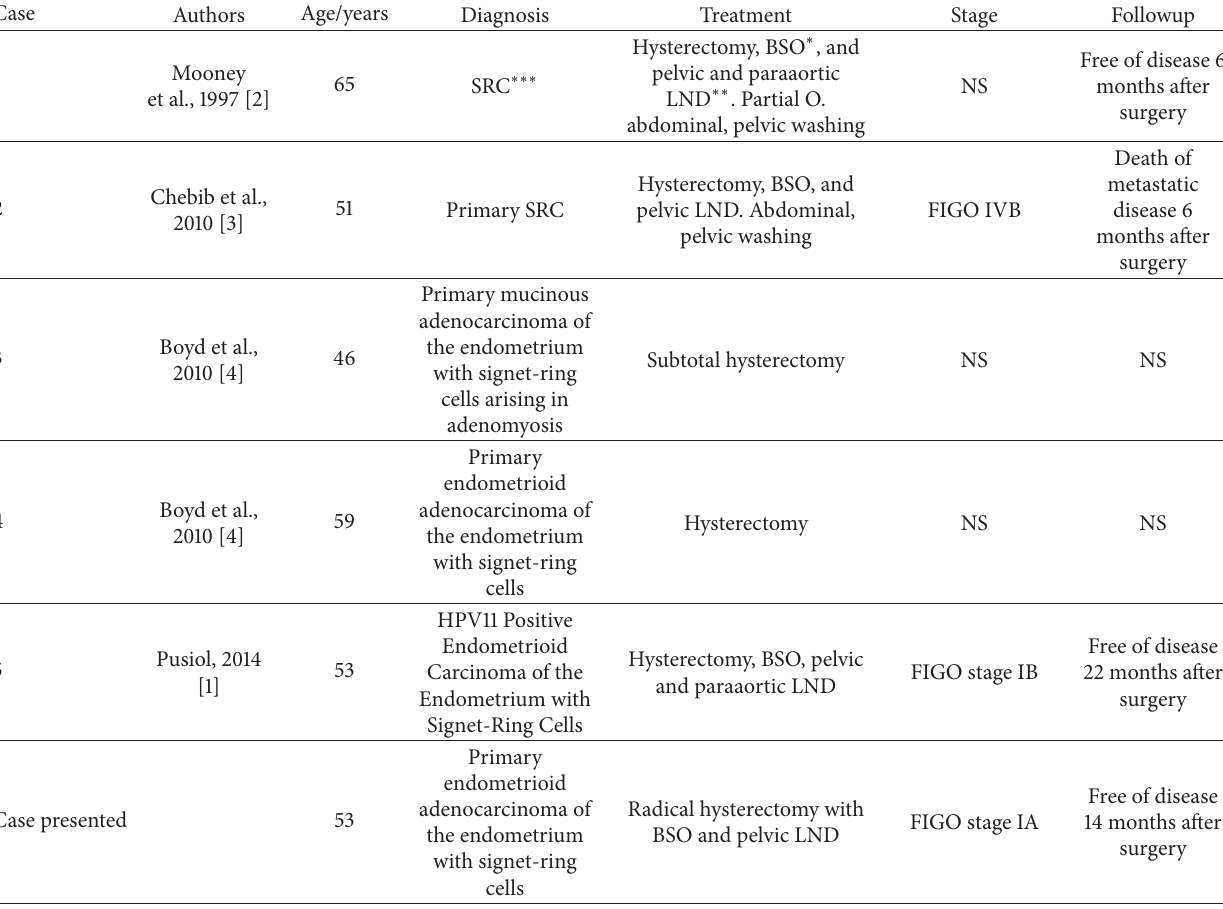
Table 1: Endometrial adenocarcinoma with signet-ring cells: review of the literature.